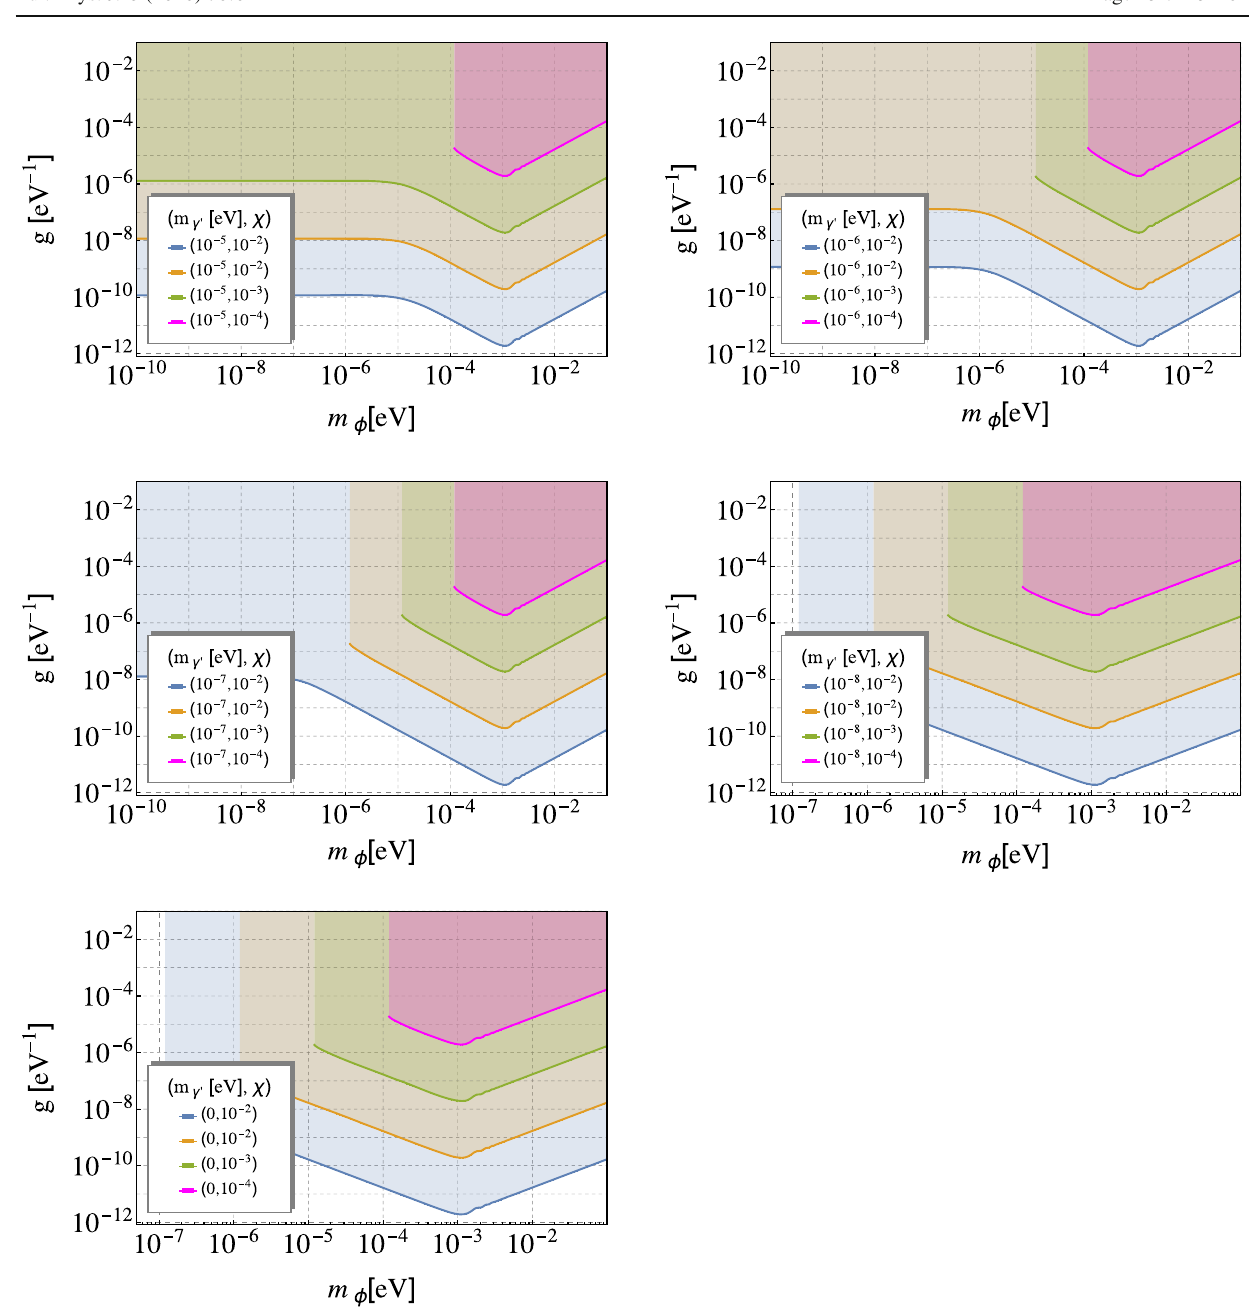
Fig. 7 Exclusion region in the ALP plane region g vs. m φ using ellipticity measurements for different pairs of HP coupling and masses. We have assumed B = 2 . 5 T, L = 1 m and ω = 1 eV from [17]. See discussion in Sect. 4.1 of the manuscript